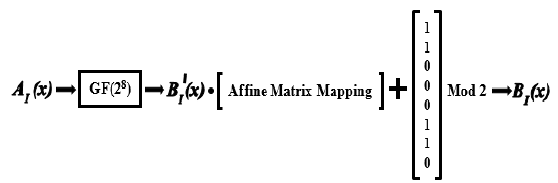
Figure 6 . How bit substitution is